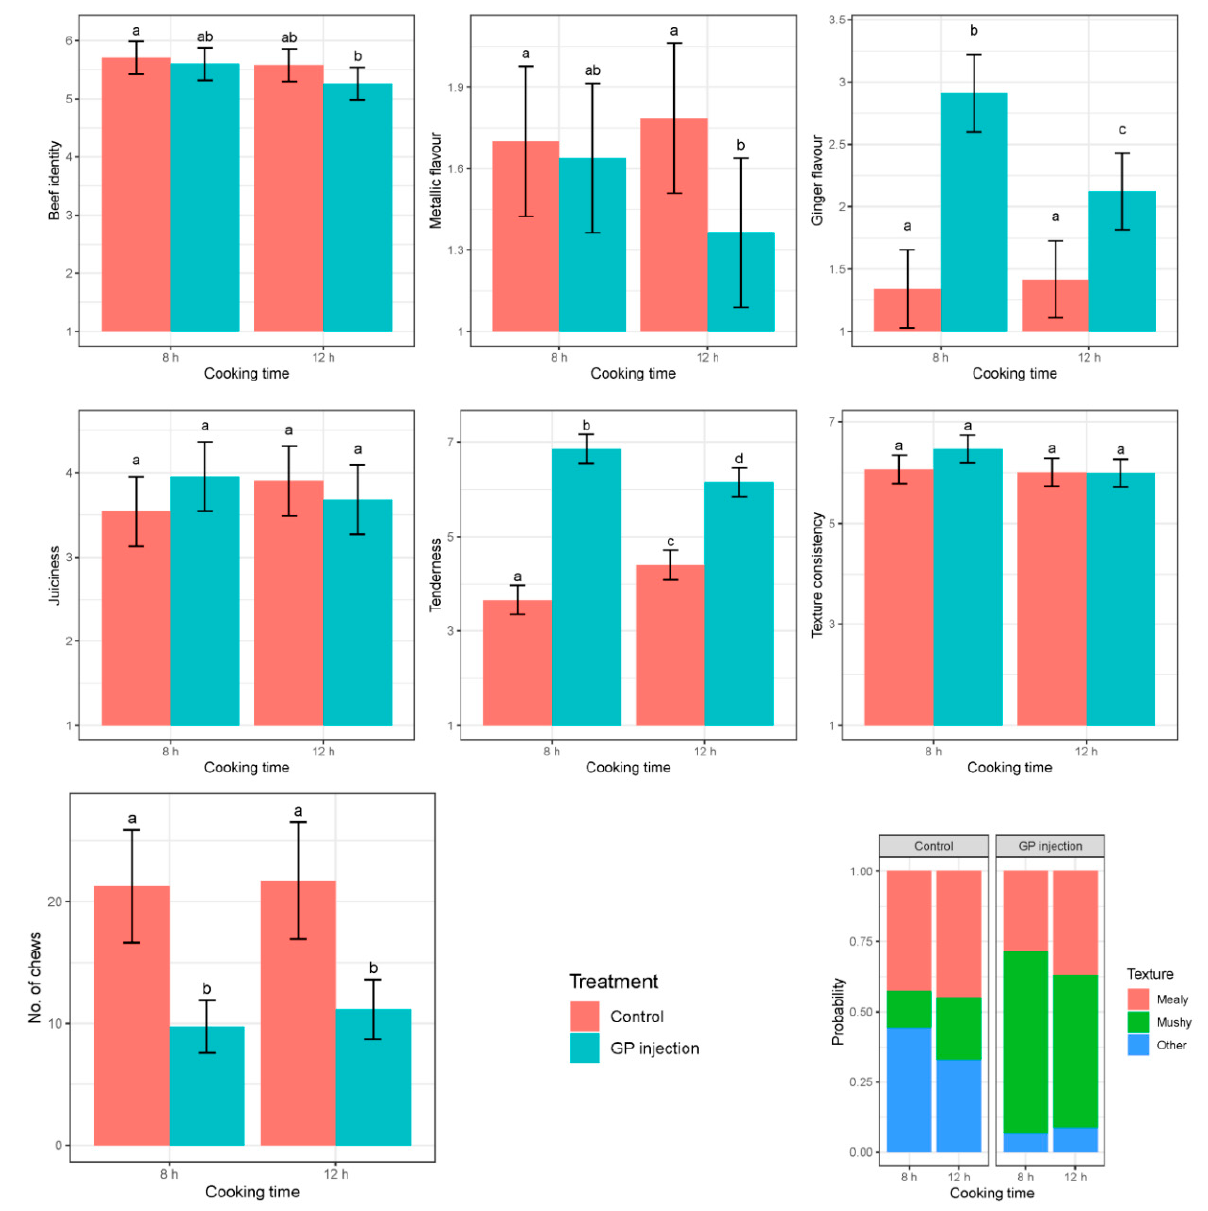
Figure 1. Effect of injection treatment (GP injection = Ginger powder solution containing zingibain injection, Control = without injection) and cooking time (8 h, 12 h) on sensory attributes of M. biceps femoris cooked at 65 °C and assessed through trained panelists. Eight-point scales were used for beef identity, metallic flavour and ginger flavour (1 = none, to 8 = extremely intense), juiciness (1 = extremely dry, to 8 = extremely juicy), tenderness (1 = extremely tough, to 8 = extremely tender), and texture consistency (1 = extremely inconsistent, to 8 = extremely uniform). Number of chews were counted by each panellist. Mean scores ± SE are presented in the bar chart for each sensory attribute and number of chews. Superscripts refer to significant differences between means. The texture description in the bottom right graph are based on a three-level categorical variable and are presented as a mean probability for the two injection treatments. A similar letter on each bar chat referring each attribute describes non-significance between